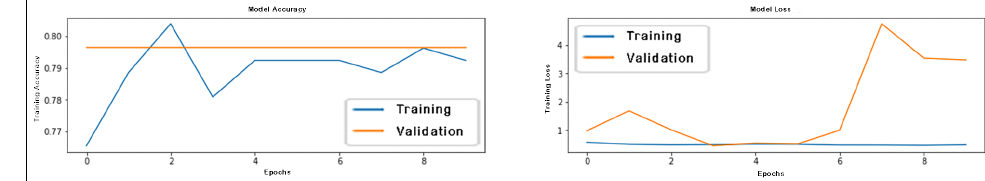
Figure 15. T2: Model accuracy and loss for 10 epochs.